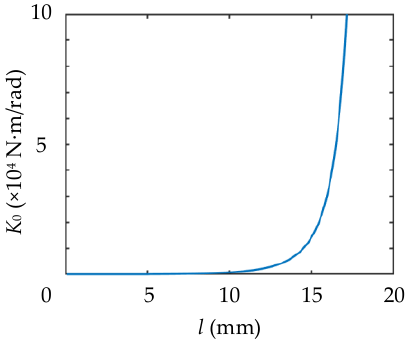
Figure 9. K 0 - l curve near the initial state .